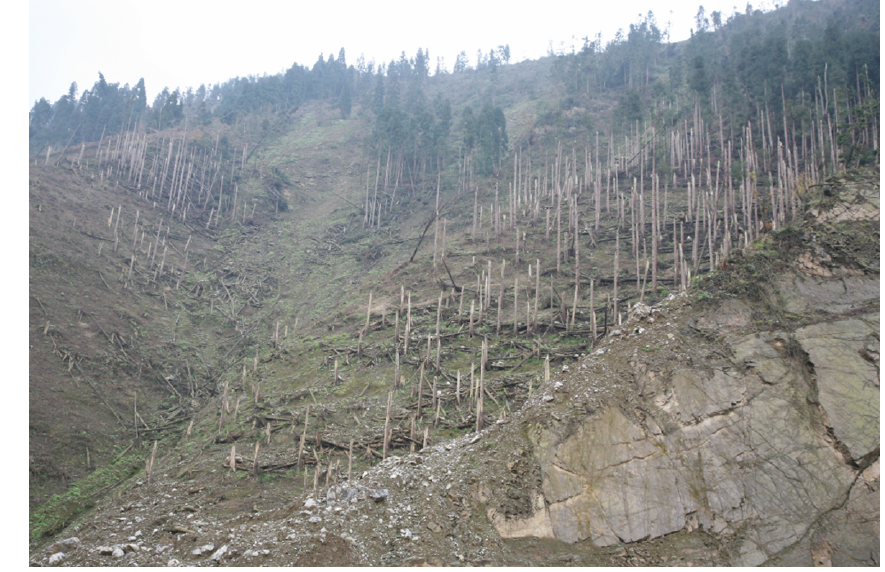
Figure 1. Tree breakage caused by a large landslide-induced air blast in Sichuan, China, 2008.